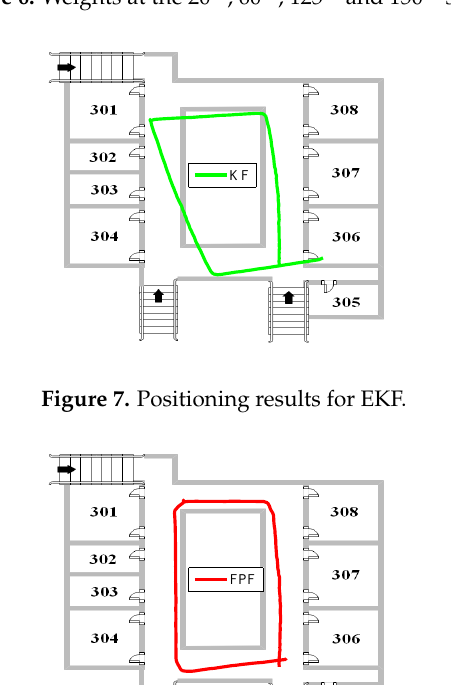
Figure 6. Weights at the 20 th , 60 th , 125 th and 150 th steps.